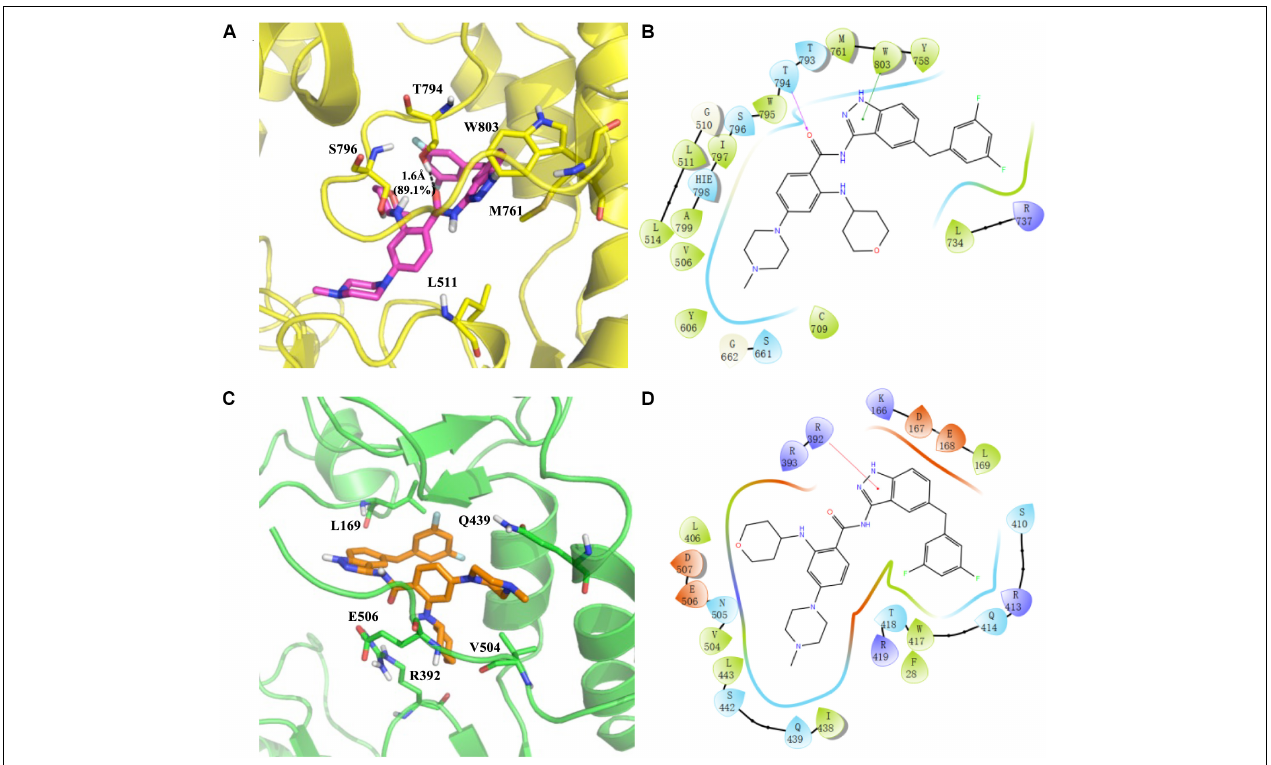
FIGURE 8 | Predicted binding sites for RAI-13 bound to DENV RdRp (A,B) and hNV RdRp (C,D) . Left panel: The polymerases are shown in cartoon representation with the backbone atoms depicted in yellow (DENV RdRp) and green (hNV RdRp). RAI-13 and the important residues for the polymerase-ligand interactions were shown as sticks. For clarity, only polar hydrogen atoms were depicted in the figures. Right panel: the 2D ligand-polymerase interaction diagrams. Residues within 4 Å of RAI-13 are displayed. Hydrogen bond is represented by the arrows with the distance between the donor and the acceptor. The (cid:117) − −(cid:117) stacking and salt bridge are shown in green and purple lines, respectively. Here the color code is that dark blue is positive charged, red is negative charged, light blue is polar, green is hydrophobic, and white is